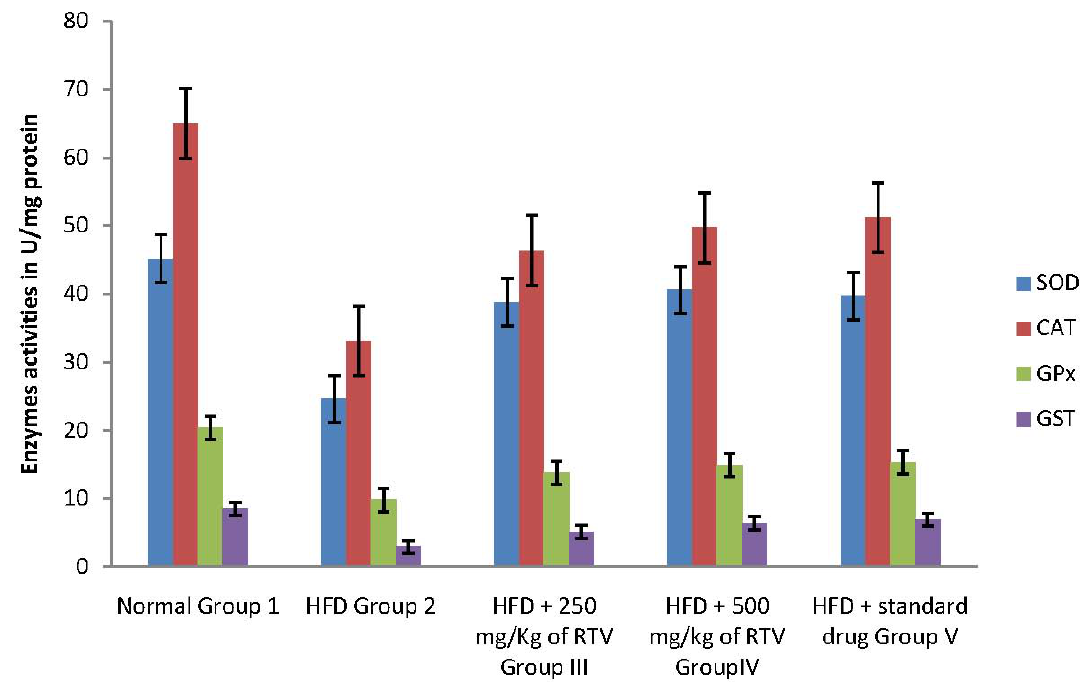
Figure 1. Effects of methanolic extract of rhizomes of T. violacea treatment on antioxidants defense viz., Superoxide dismutase (SOD), Catalase (CAT), glutathione peroxidase (GPx), and glutathione-S-transferase (GST) in high fat diet induced oxidative stress in rat liver